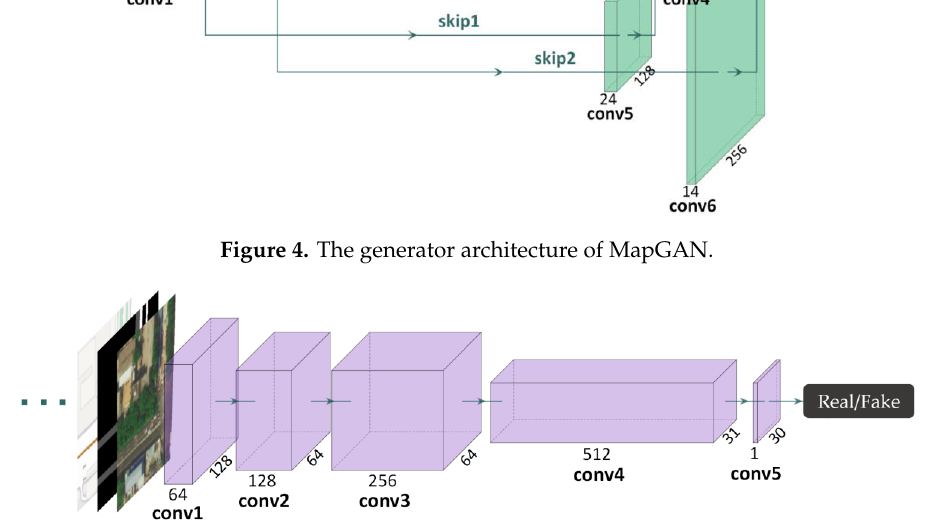
Figure 4. The generator architecture of MapGAN.